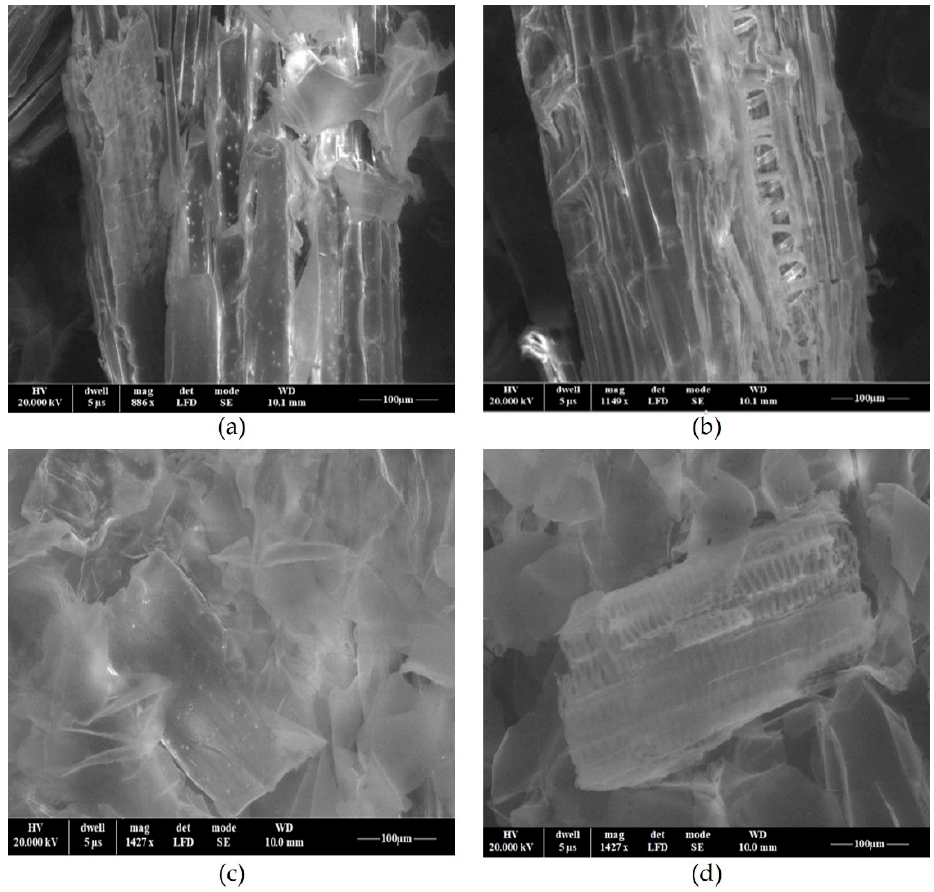
Figure 10. SEM images of MS at 1147 × ( a ), 886 × ( b ), 1427 × ( c and d ) magnification before ( a – b ) and after ( c – d )